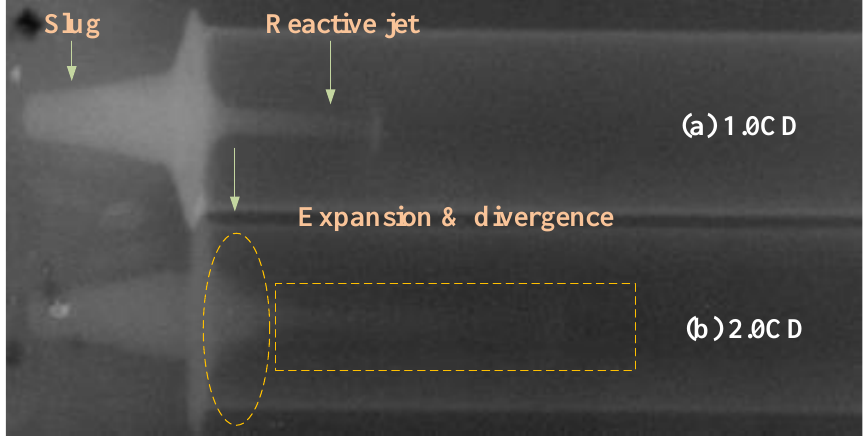
Figure 19. X-ray image of reactive composite jet formation ( a ) t = 15 μs and ( b ) t = 21